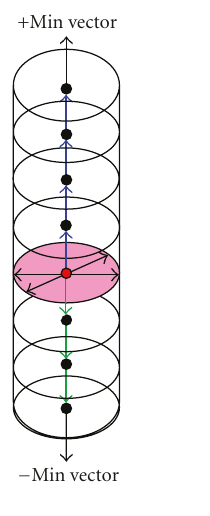
Figure 5: Scheme of the tracing procedure along a single fiber. New center points are determined by tracing along the minimum eigenvector in two directions. Additionally, a circular area is filled using the other eigenvectors as a basis with a previously known radius.